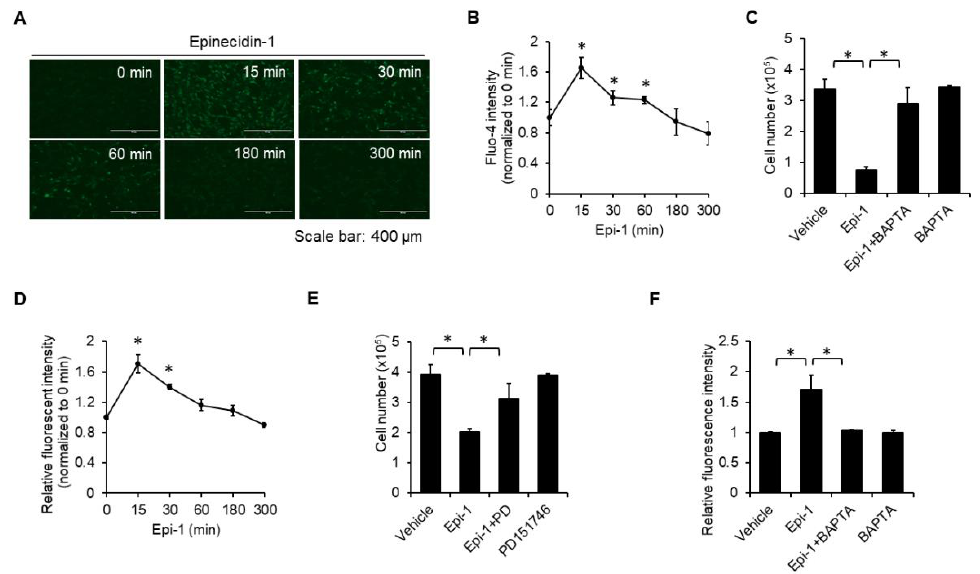
Figure 3. Calcium-dependent calpain activation is required for epi-1-mediated cytotoxicity. Cells were preloaded with Fluo-4 (5 μM) for 15 min, then treated with epi-1 at different points as indicated. Fluorescence of Fluo-4 was observed by fluorescence microscopy ( A ) and flow cytometry ( B ). ( C ) Cells were preincubated with BAPTA (BA; 10 μM) for 1 h, followed by epi-1 for an additional 5 h. Cytotoxicity was assessed by the trypan blue exclusion assay. ( D ) Cells were preloaded with fluorogenic calpain substrate t-BOC (10 μM) for 30 min, followed by epi-1 for the indicated times. ( E ) Cells were preincubated with PD151746 (PD) for 1 h, followed by epi-1 for an additional 5 h. Cytotoxicity was determined by the trypan blue exclusion assay. ( F ) Cells were pretreated with BA